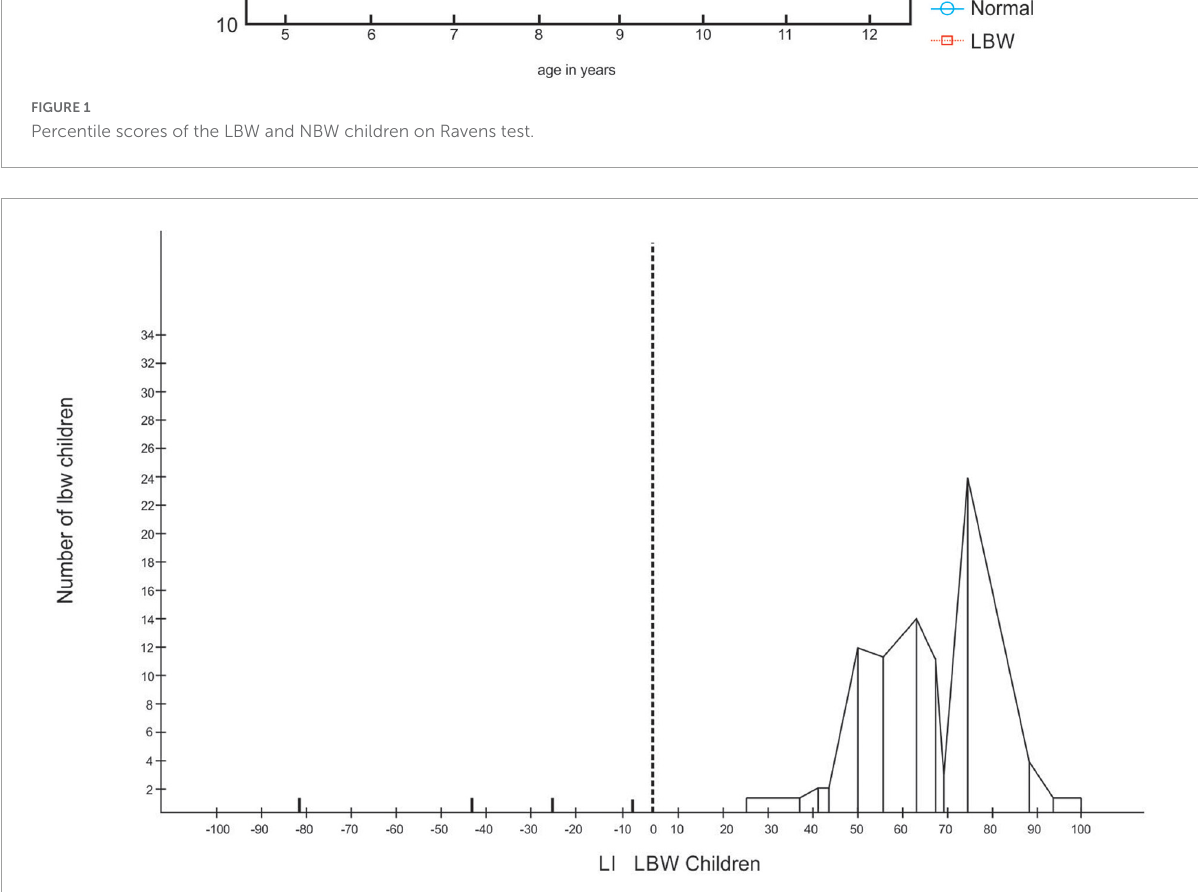
FIGURE2 Laterality index (LI) for low-birthweight (LBW) children.